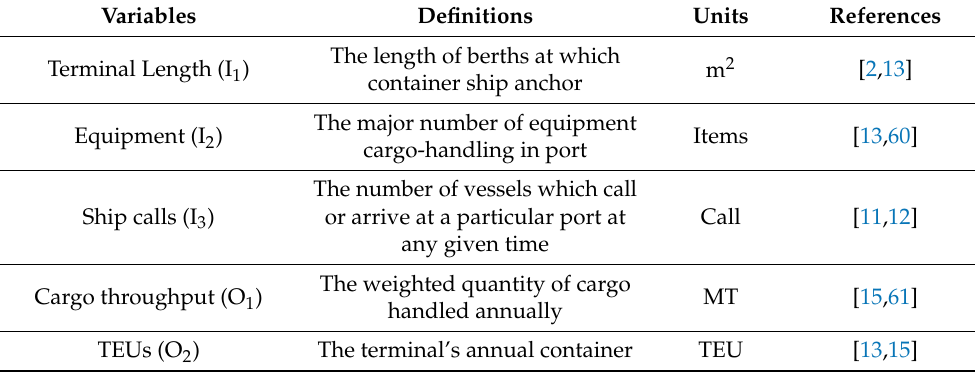
Table 3. Definitions of variables.